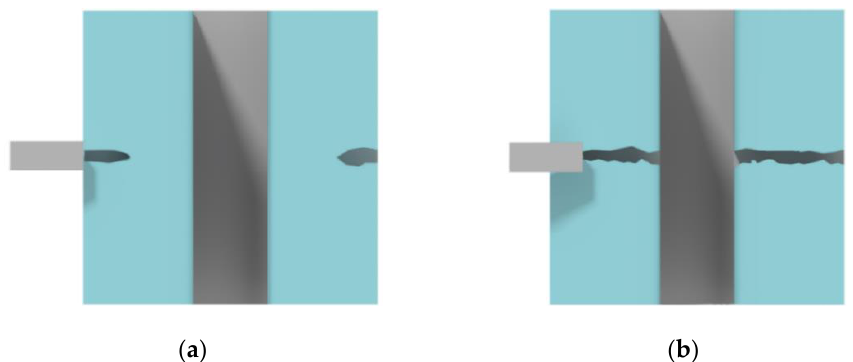
Figure 4. The standard approach for sample cleaving with high trenches in silicon: ( a ) Small scratch near the trench; ( b ) Long scratch crossing the trench.